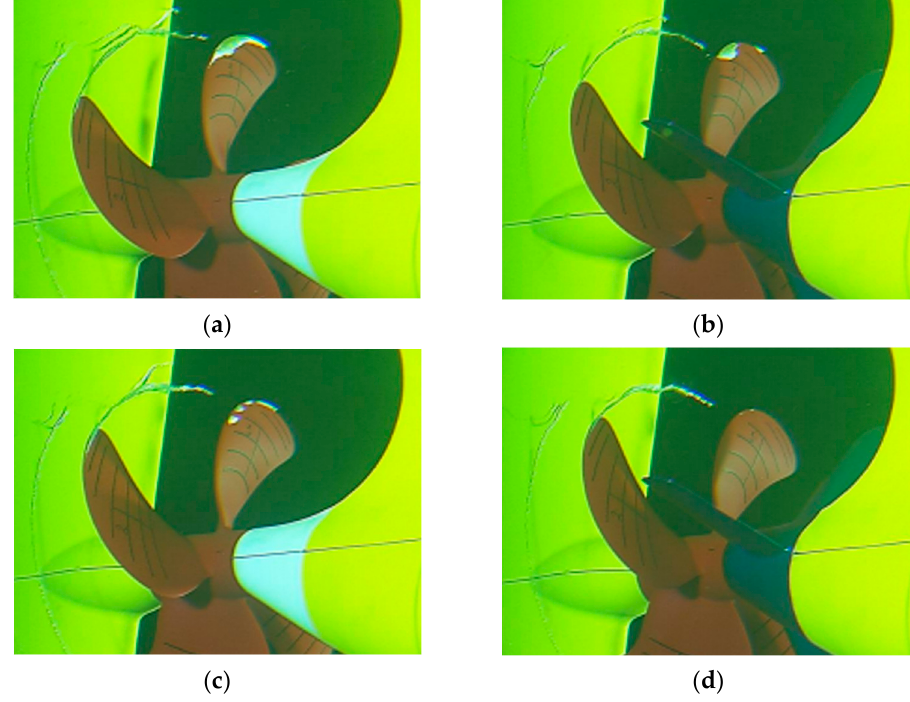
Figure 19. Photos of cavity for Bare and with ESD ( a , b ) θ = 280 ◦ ; ( c , d ) θ = 290 ◦ .